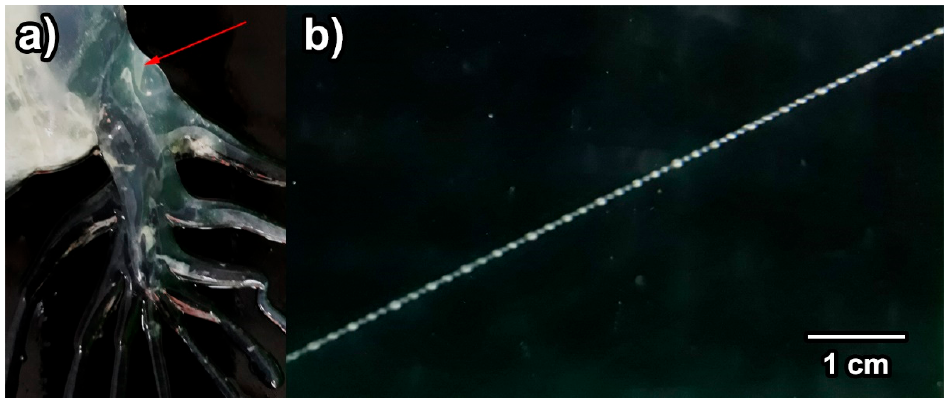
Figure 2. Identifying characteristics of box jellyfish Chironex yamaguchii : ( a ) Pedalia showing 9 tentacles attached and the volcanic-shaped pedalial canal bend (red arrow). ( b ) Clusters of nematocysts on the tentacles of box jellyfish Chironex yamaguchii .